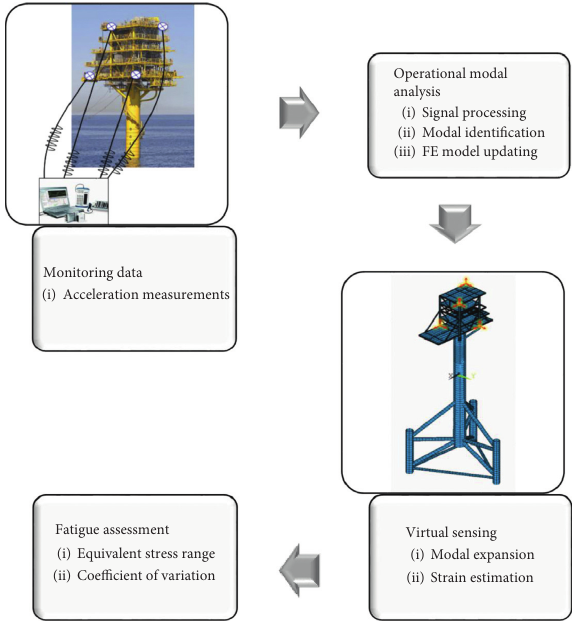
Figure 1: Methodology general